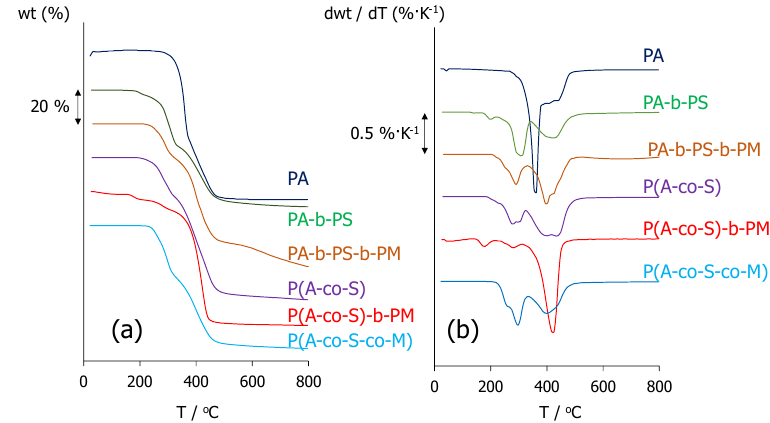
Figure 2. ( a ) Thermogravimetric (TG) and ( b ) derivative thermogravimetric (DTG) curves of polymers containing MeOAzB and AMPS groups. The mesogenic homopolymer (PA) has been included for the sake of reference. Curves have been shifted arbitrarily along the Y-axes.